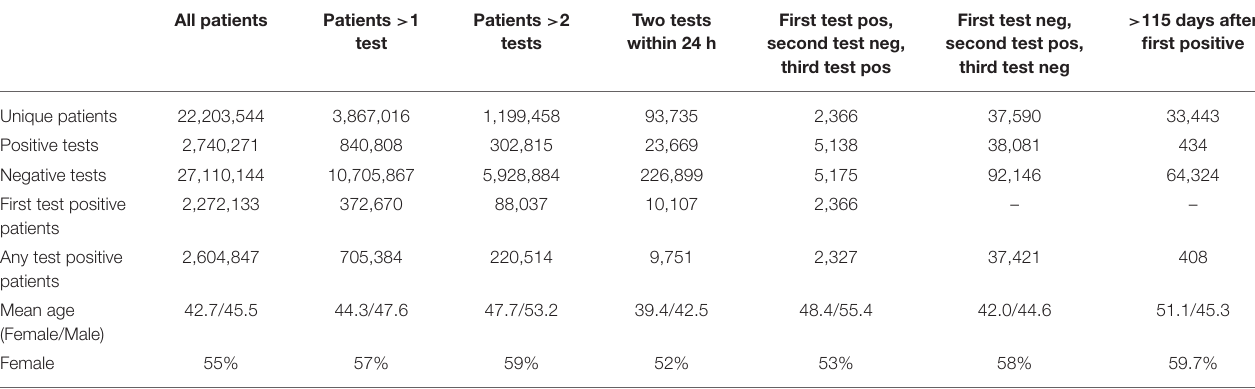
TABLE 1 | General demographics of testing results for SARS-CoV-2 RT-PCR testing. All